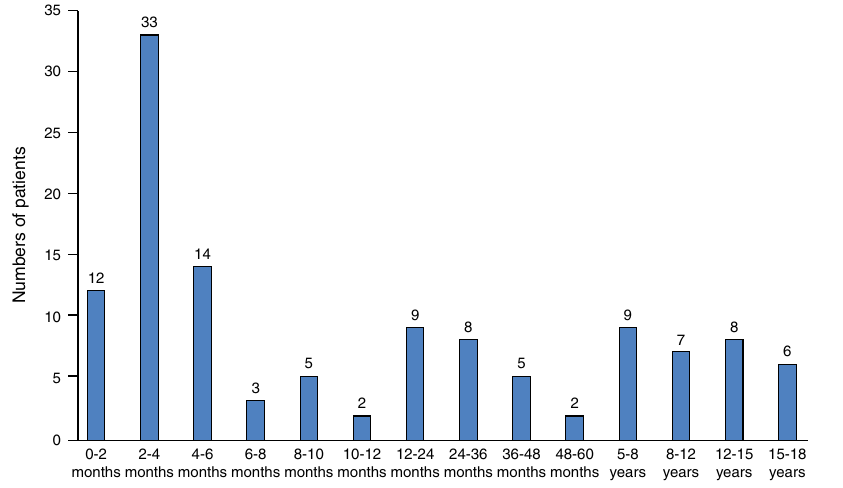
Figure 1 Distribution of patients in regard to their age.